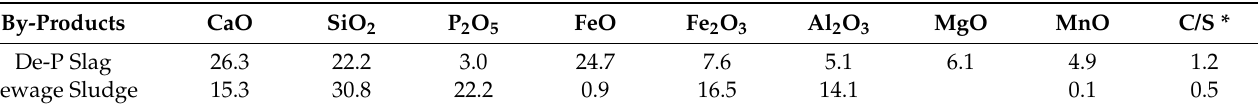
Table 1. Examples of composition of steelmaking slag and sewage sludge (in mass%).